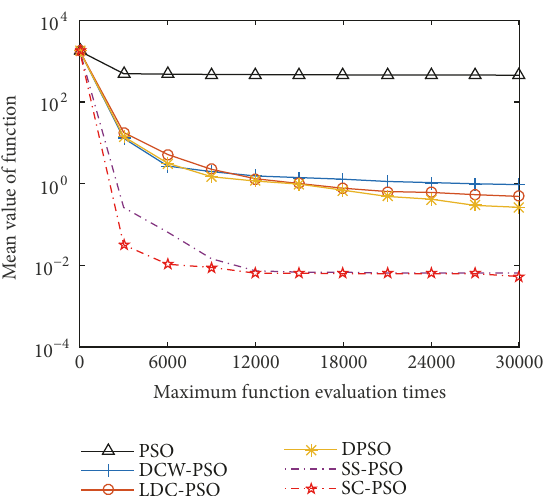
Figure 4: The function f 2 iterates over the curve.